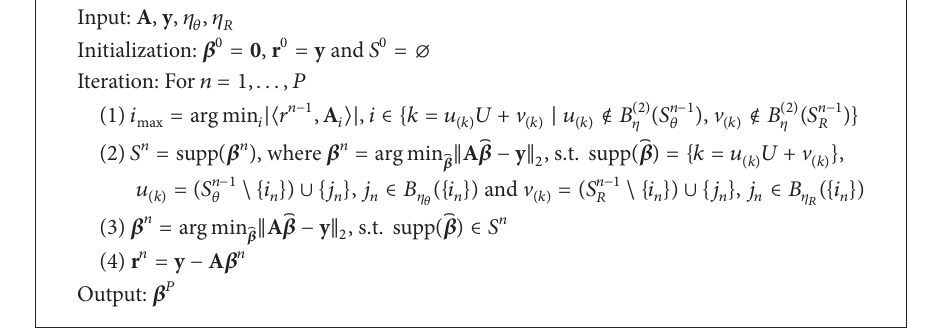
Algorithm 1: 2D BLOOMP algorithm.